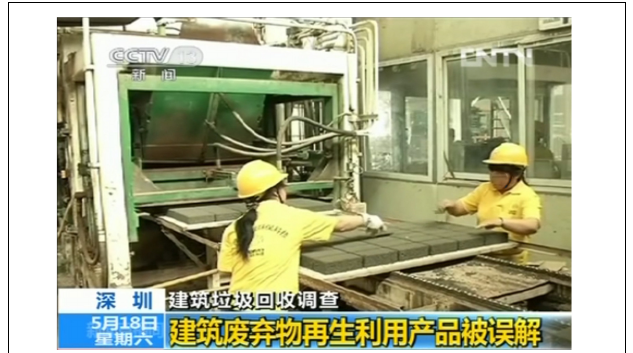
FIGURE 3 | Sample video screenshot. Source: China Internet TV.